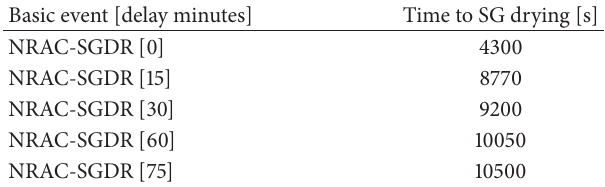
Table 3: Time to the SG drying.